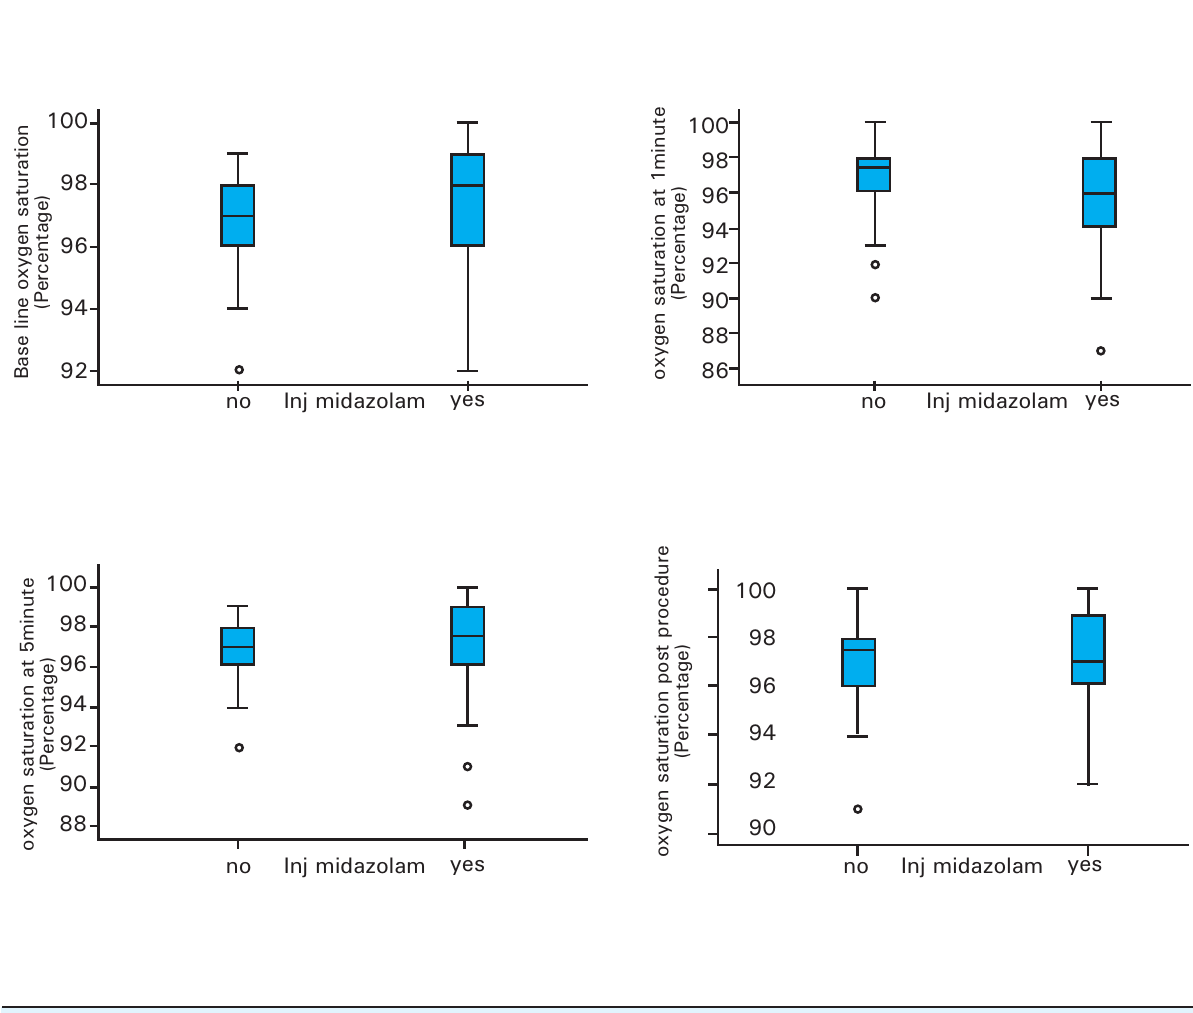
Figure 2. Changes in oxygen saturation between two groups at different stages of